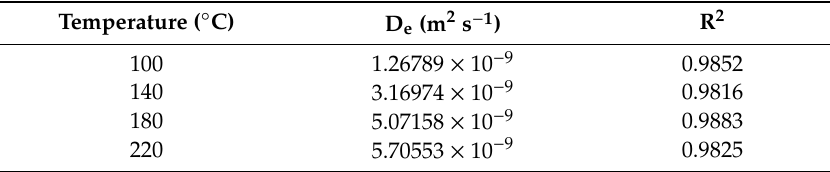
Table 5. Moisture di ff usivity coe ffi cient in the Fick